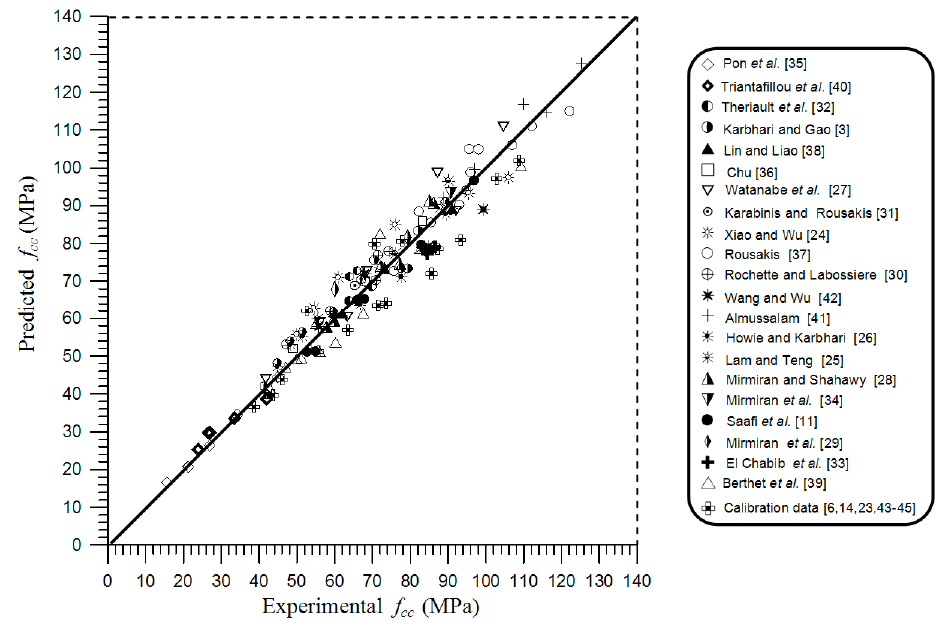
Figure 8. Predicted versus experimental ultimate compressive strengths according to modified Johnston